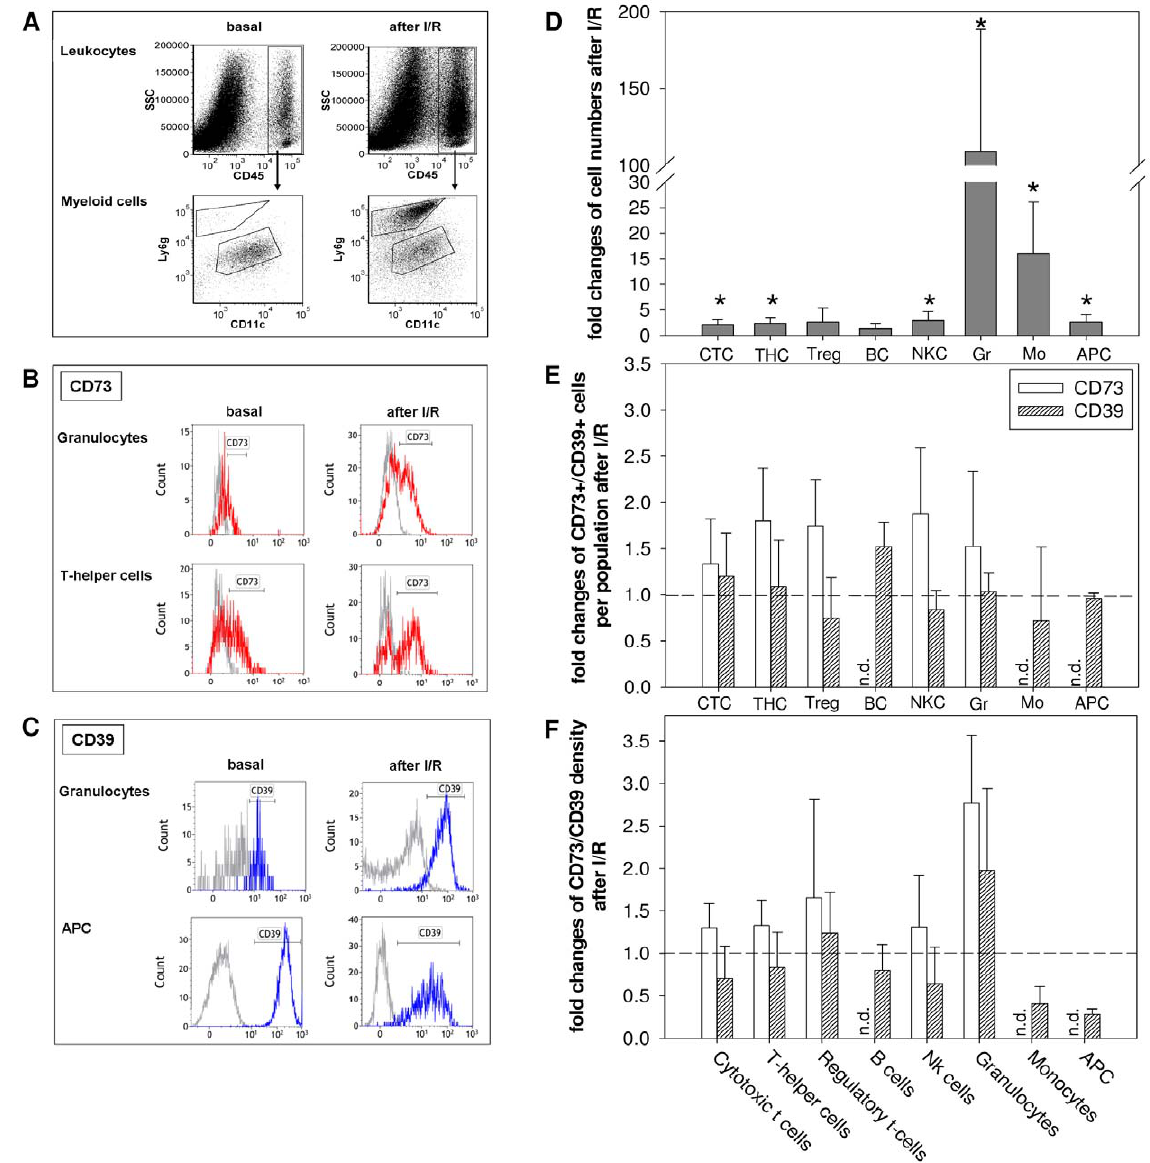
Figure 4. Changes of total leukocytes, CD73 + /CD39 + cells and CD73/CD39 surface density after I/R. A : Representative flow cytometry plots of digested hearts under basal conditions compared to 3 days after I/R. B : Representative flow cytometry histograms of CD73 expression (red) under basal conditions compared to 3 days after I/R. Grey histograms=fluorescence minus one control (FMO). C : Representative flow cytometry histograms of CD39 expression (blue). Grey histograms=fluorescence minus one control (FMO). D : Increase of leukocyte populations within myocardial tissue after I/R. * P , 0.05 for cells/mg heart tissue under basal conditions vs. I/R. CTC=cytotoxic t-cells, THC=T-helper cells, Treg=regulatory t-cells, BC=B-cells, NKC=NK cells, Gr=Granulocytes, Mo=Monocytes, APC=Antigen-presenting cells. E : Changes of CD73 + /CD39 + cells per leukocyte population after I/R. F : Changes of CD73/CD39 surface density on CD73 + /CD39 + leukocytes after I/R. Analysis was done 3 days after I/R. Values are means 6 SD of n=5 experiments. n.d.=not detectable.